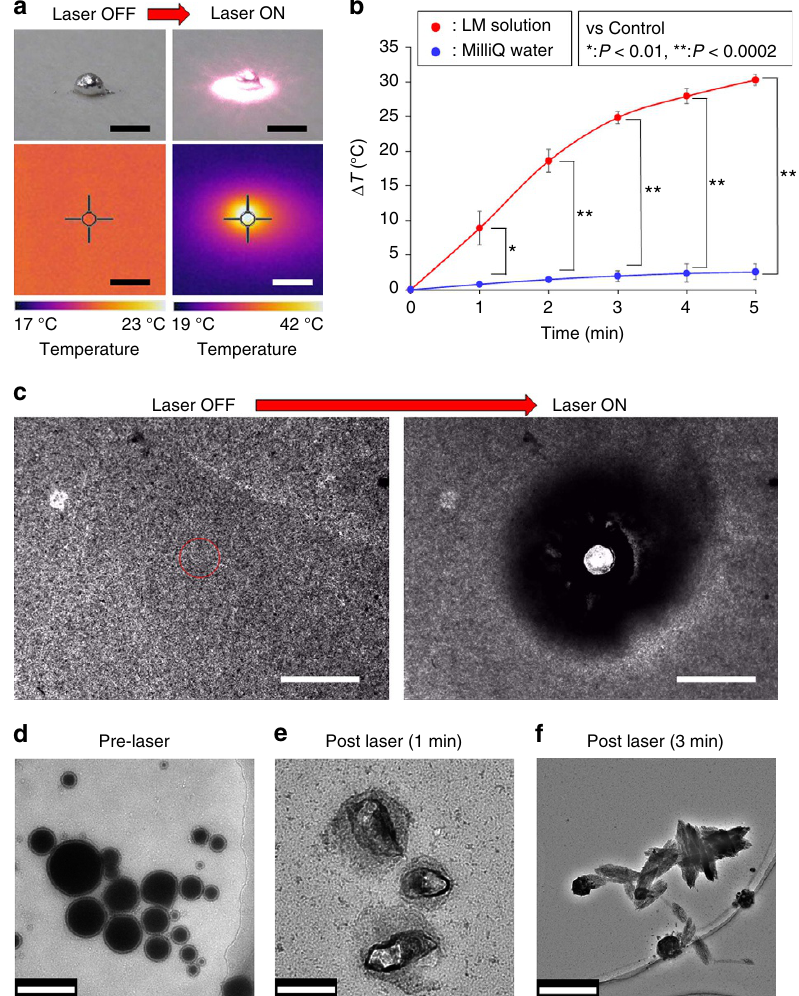
Figure 3 | Laser-induced morphological changes in LM nanocapsules. ( a ) Visible light and thermographic images of a representative LM droplet (1mg) before and after irradiation with a 785nm NIR laser at 1W ( B 80mWmm (cid:2) 2 ) for 5min. Scale bars, 2mm. ( b ) Thermal response of a 100 m gml (cid:2) 1 DSPE-PEG 2000 -Amine-DC(8,9)PC-LM solution by a laser source (785nm, 1W, B 80mWmm (cid:2) 2 ). Error bars represent s.d.’s of three separate measurements. * P o 0.01; ** P o 0.0002. ( c ) Laser-promoted degradation of DSPE-PEG 2000 -Amine-DC(8,9)PC-LM nanoconjugates before and after laser irradiation (808nm, 564mW, B 287 m W m m (cid:2) 2 ). The red circle shows laser irradiation position and area. Scale bars, 100 m m. ( d – f ) TEM images of LM nanocapsules ( d ) before and after laser irradiation for ( e ) 1 and ( f ) 3min (785nm, 1W, B 80mWmm (cid:2) 2 ). Scale bars, 200nm ( d ); 100nm ( e ); and 500nm ( f